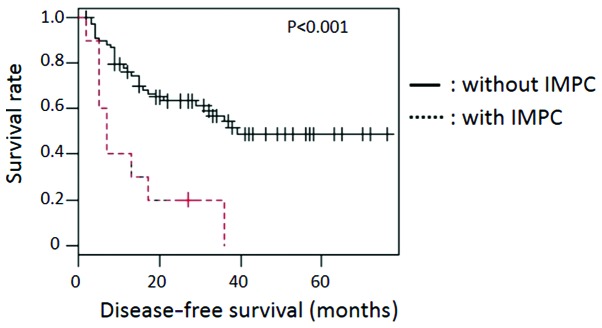
DFS rate of patients with IMPC component. Patients with IMPC component showed reduced DFS (P<0.001). DFS, disease-free survival; IMPC, invasive micropapillary carcinoma.